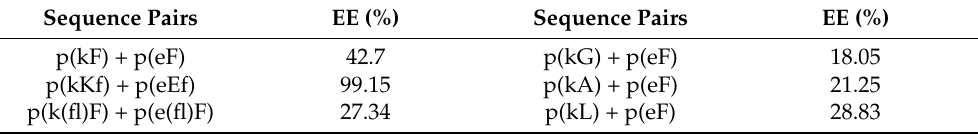
Table 4. Encapsulation efficiency (EE %) of sequence pairs for methylene blue (MB), calculated based on comparison of area under the absorbance spectra of supernatant solutions with methylene blue